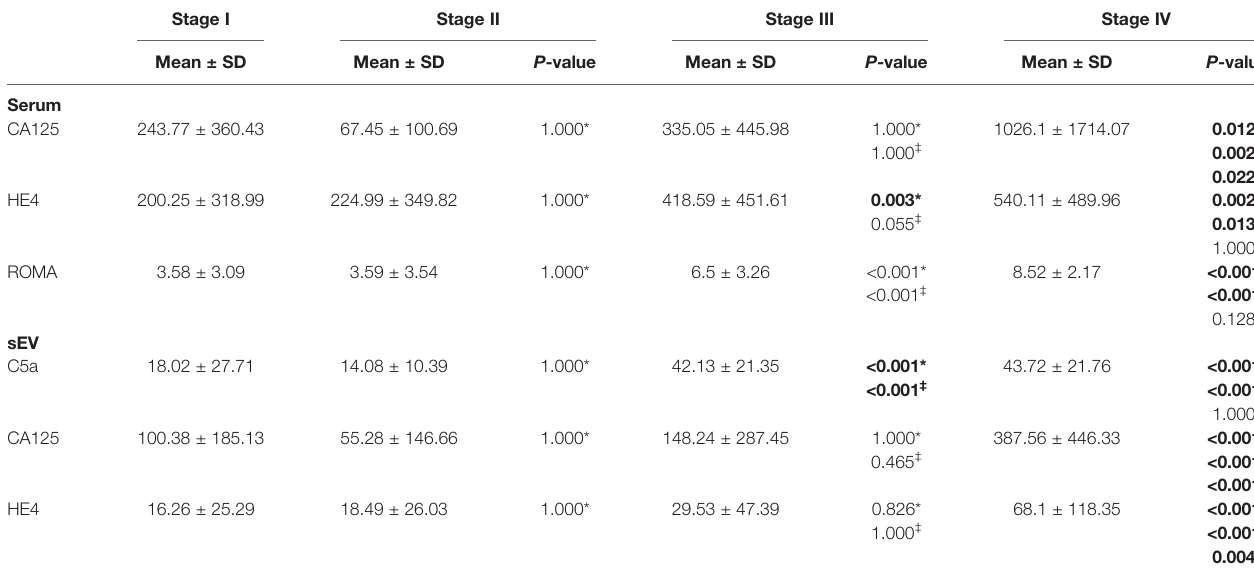
TABLE 5 | Serum protein and sEV protein levels in the EOC FIGO